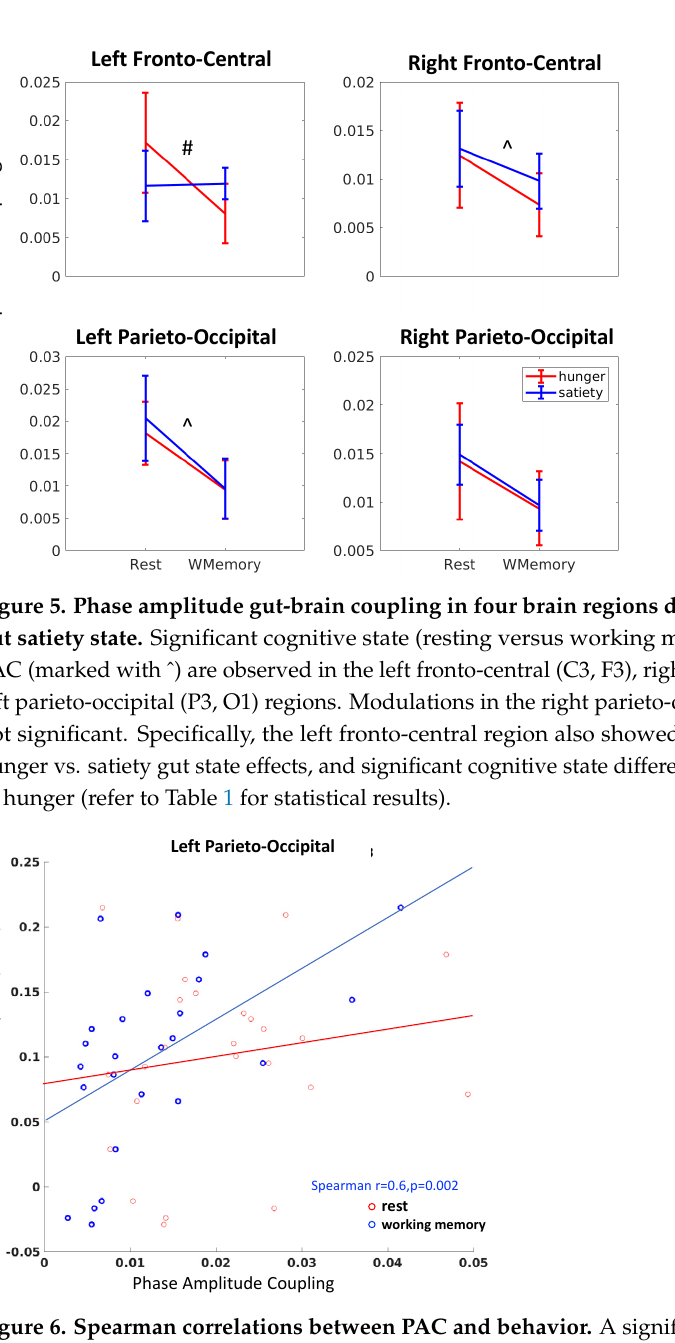
Figure 6. Spearman correlations between PAC and behavior. A significant relationship was found between PAC during the working memory task and performance speed, with increased coupling corresponding to enhanced performance speed (r = 0.6, p = 0.002).